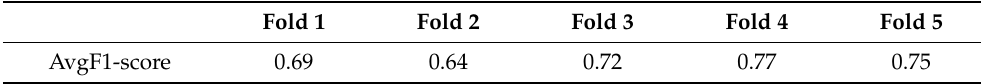
Table 2. Results of the five-fold